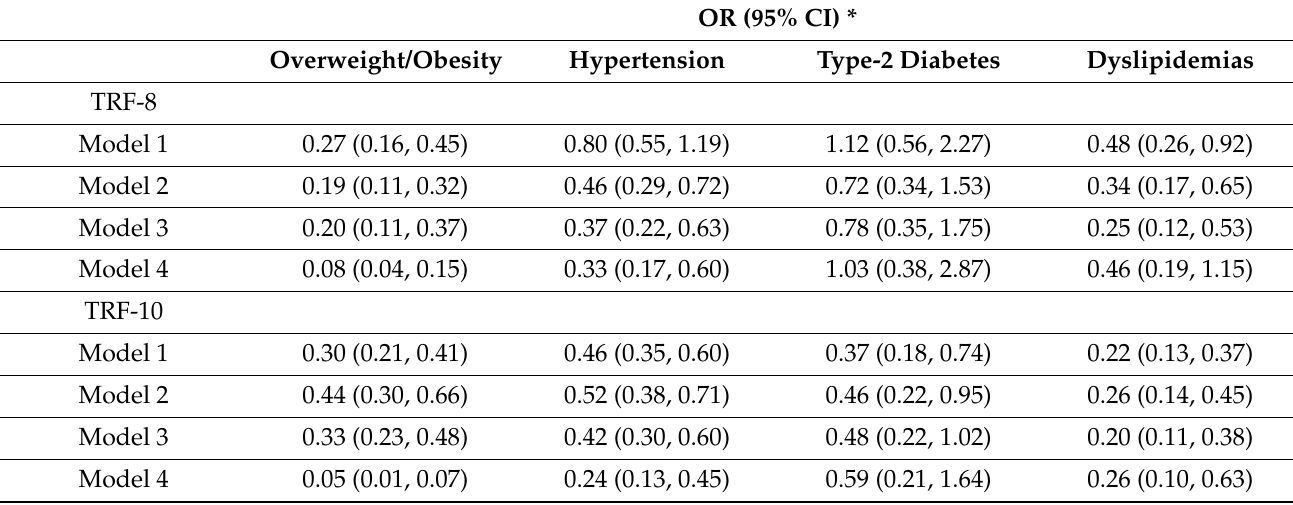
Table 3. Association between time-restricted feeding duration and main outcomes of interest in the study